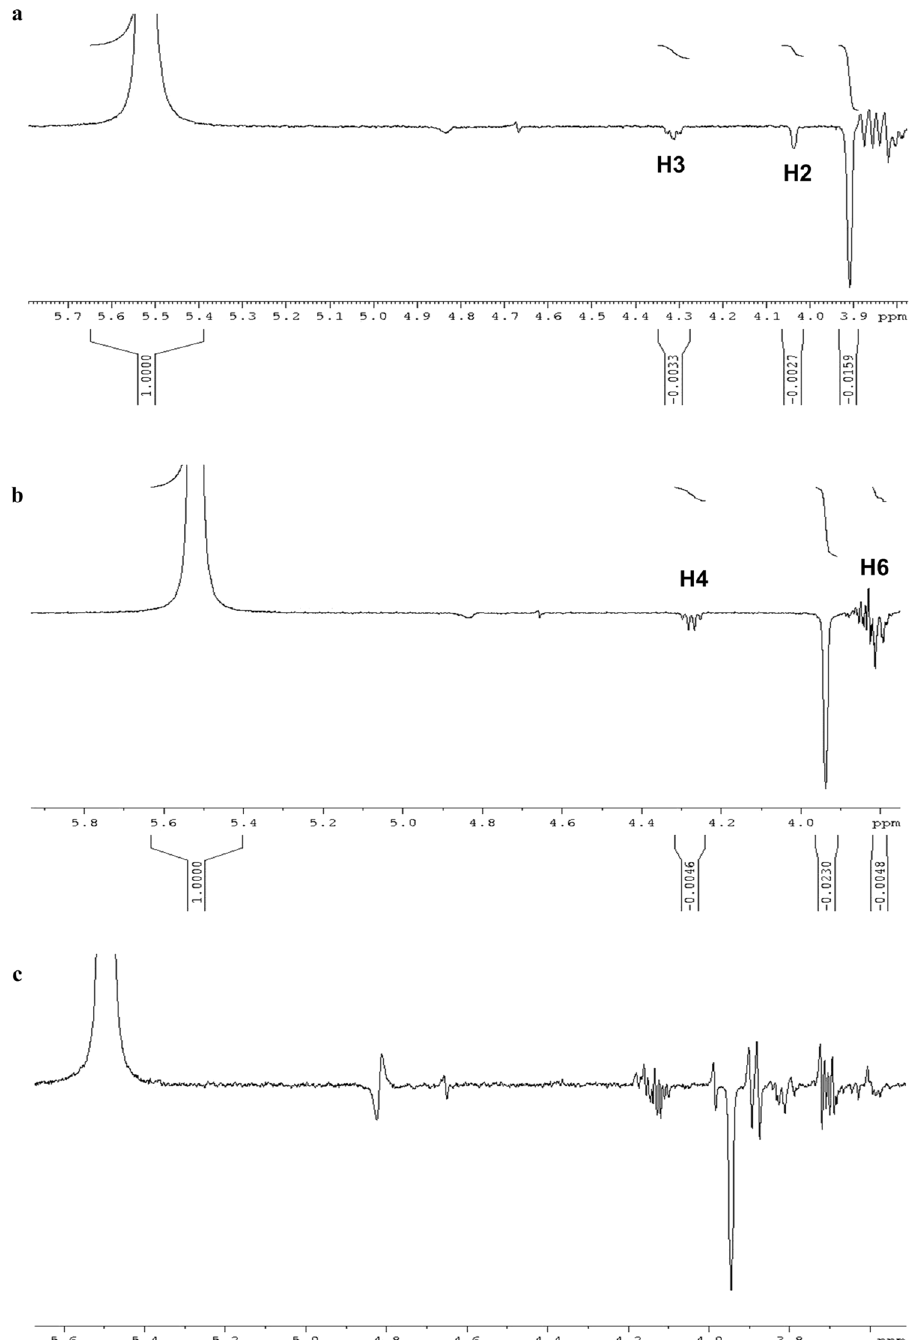
Figure 5. Fragments of 1D NOESY spectra for compounds 1 (A), 2 (B) and 3 ( C ).